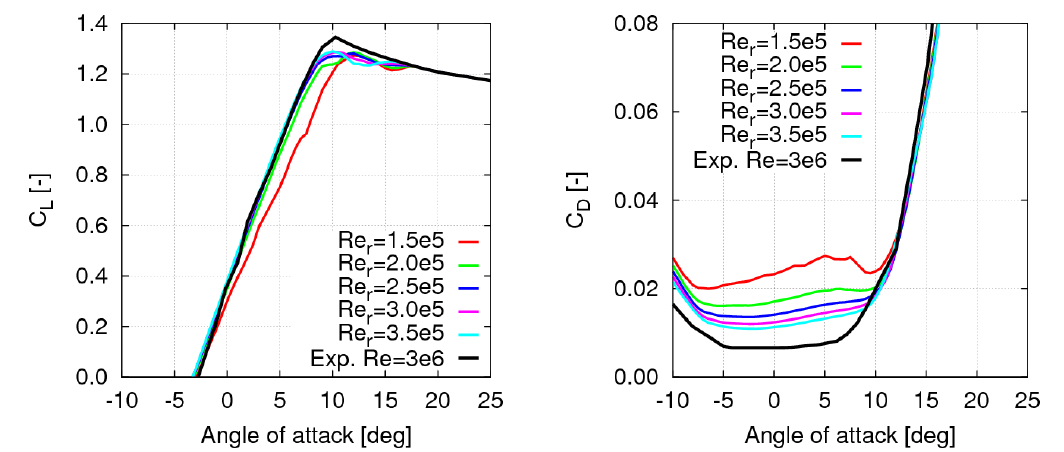
Figure 10. NACA 63-421 2D foil: lift ( left ) and drag ( right ) coefficients calculated by X-Foil and from experiments